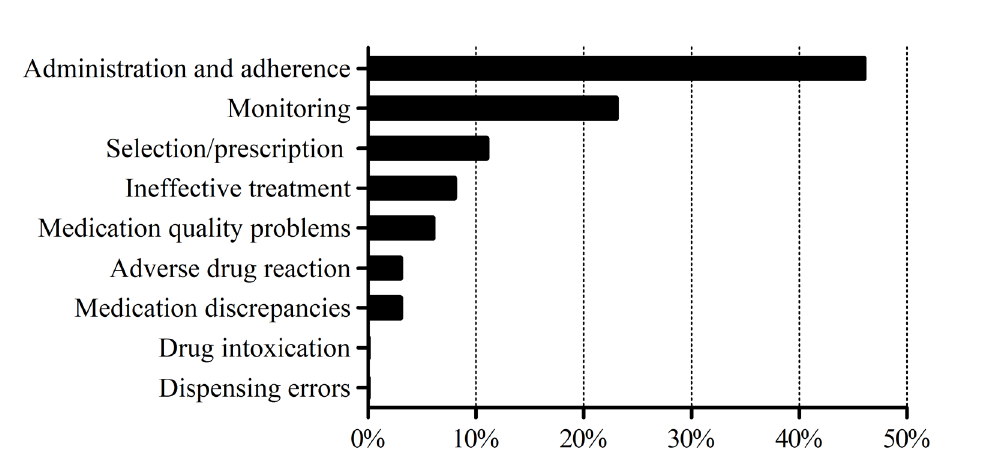
FIGURE 1 - Analysis of DTPs by category (n=115).